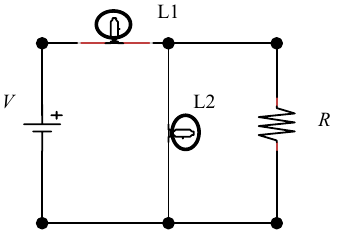
Fig. 3. The variation of the circuit’s total resistance and the brightness of a lamp